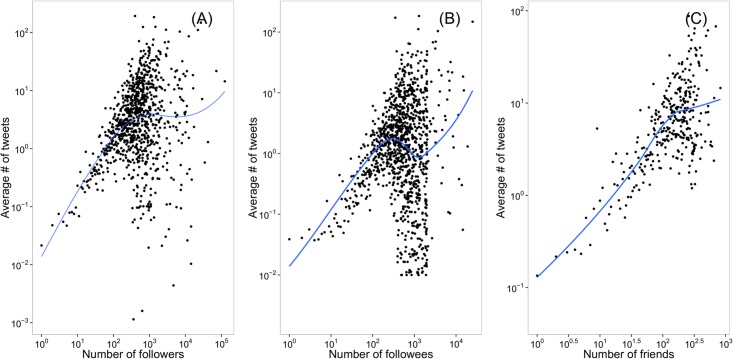
Content productivity and attention received.The average number of tweets as a function of (A) the number of followers, (B) the number of followees, and (C) the number of friends. Friend here is defined as a user who has been mentioned at least twice in an ego’s timeline.